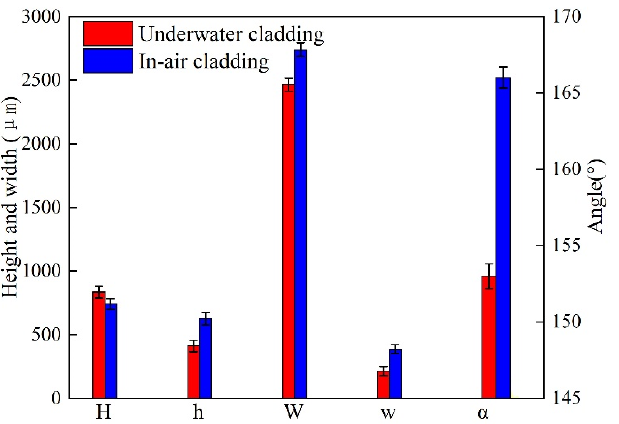
Figure 5. The cross-sectional dimensions of the in-air and underwater cladding